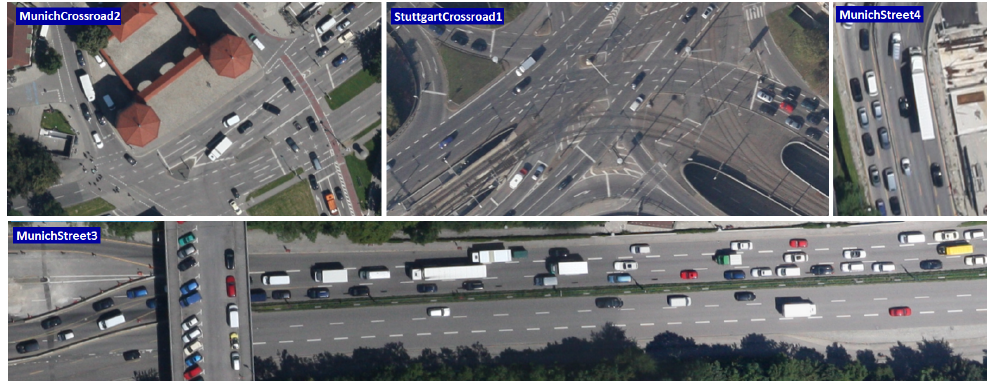
Figure 3. Sample images from the KIT AIS vehicle dataset acquired at different locations in Munich and Stuttgart, Germany.